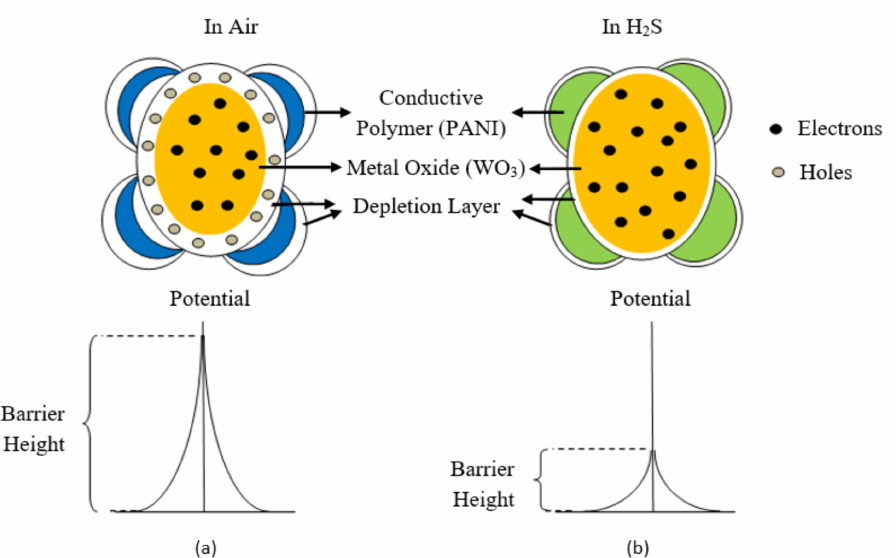
Figure 29. ( a ) Formation of depletion layer as result of inosorbed oxygen and p–n junction at the surface of PANI/WO 3 composite film. ( b ) Reduction in potential barrier due to thinning of depletion layer resulting in charge transport between PANI and WO 3